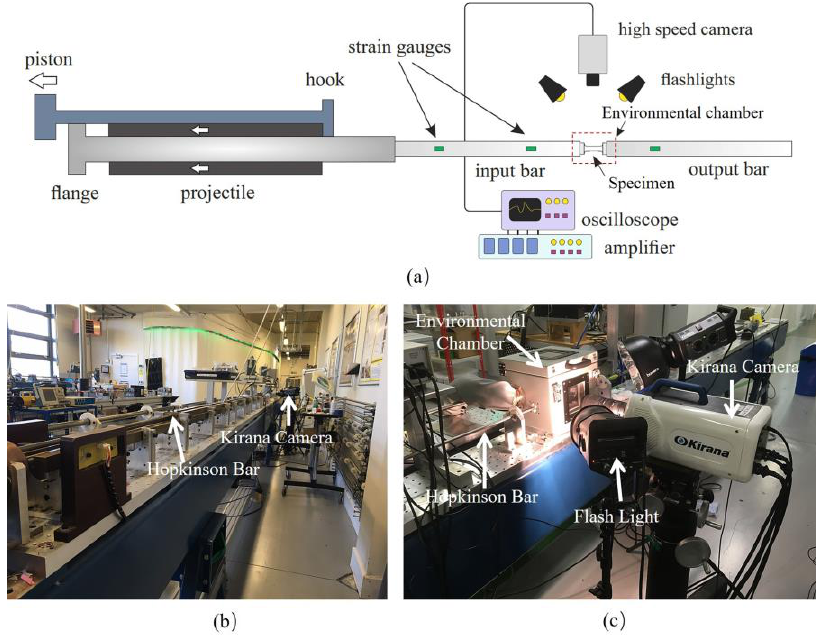
Fig.1 Experimental Setup (a) Schematic of the experimental setup (b) Image of SHTB System (b) Image of Kirana and the environmental chamber setups for elevated temperature